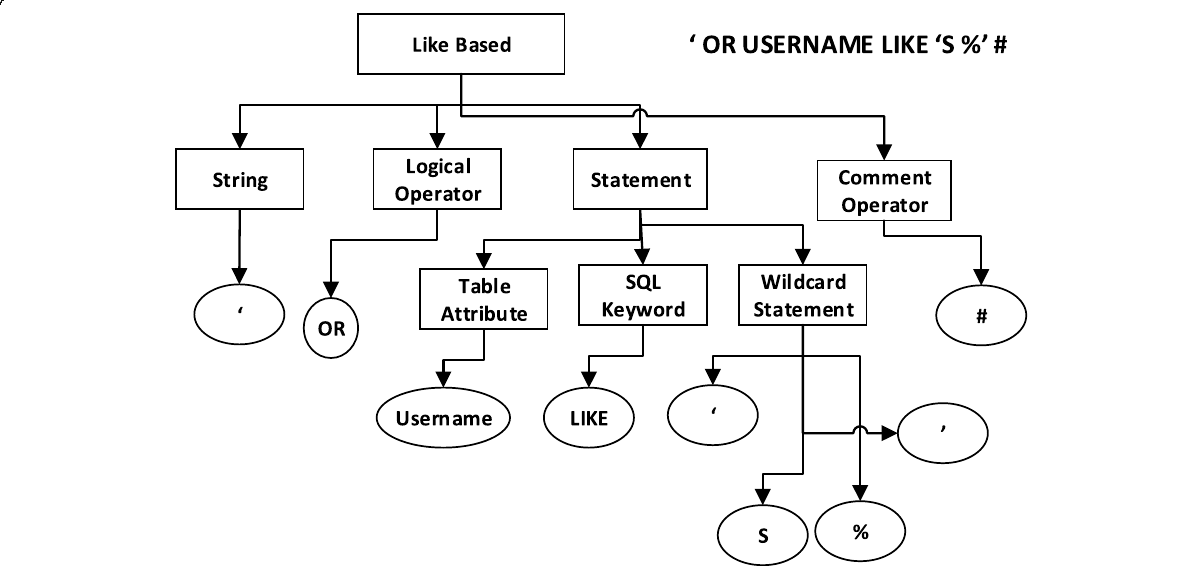
Fig. 5 Parse tree to depict like-based injection attacks. (ii). XSS injection attacks